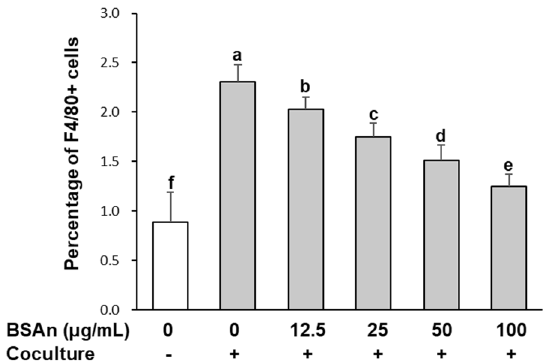
Figure 2. Effect of black soybean anthocyanin extract (BSAn) on transmigration of macrophages toward adipocytes. Hypertrophied 3T3-L1 adipocytes were cocultured with RAW264.7 macrophages for 24 h and then treated with BSAn for 24 h in the Transwell system. The number of cells labeled with F4/80 monoclonal antibody in a lower well was counted and result was expressed as percentage of F4/80+ cells. Data are presented as mean ± SD of three independent experiments. a,b,c,d,e,f Means without the same letter are significantly different by ANOVA, followed by Duncan’s test ( p < 0.001). +: adipocytes were cocultured with macrophages, -: adipocytes were cultured alone2.3. Black Soybean Anthocyanins Alleviate Inflammatory Responses in the Coculture of Adi- pocytes and Macrophages.